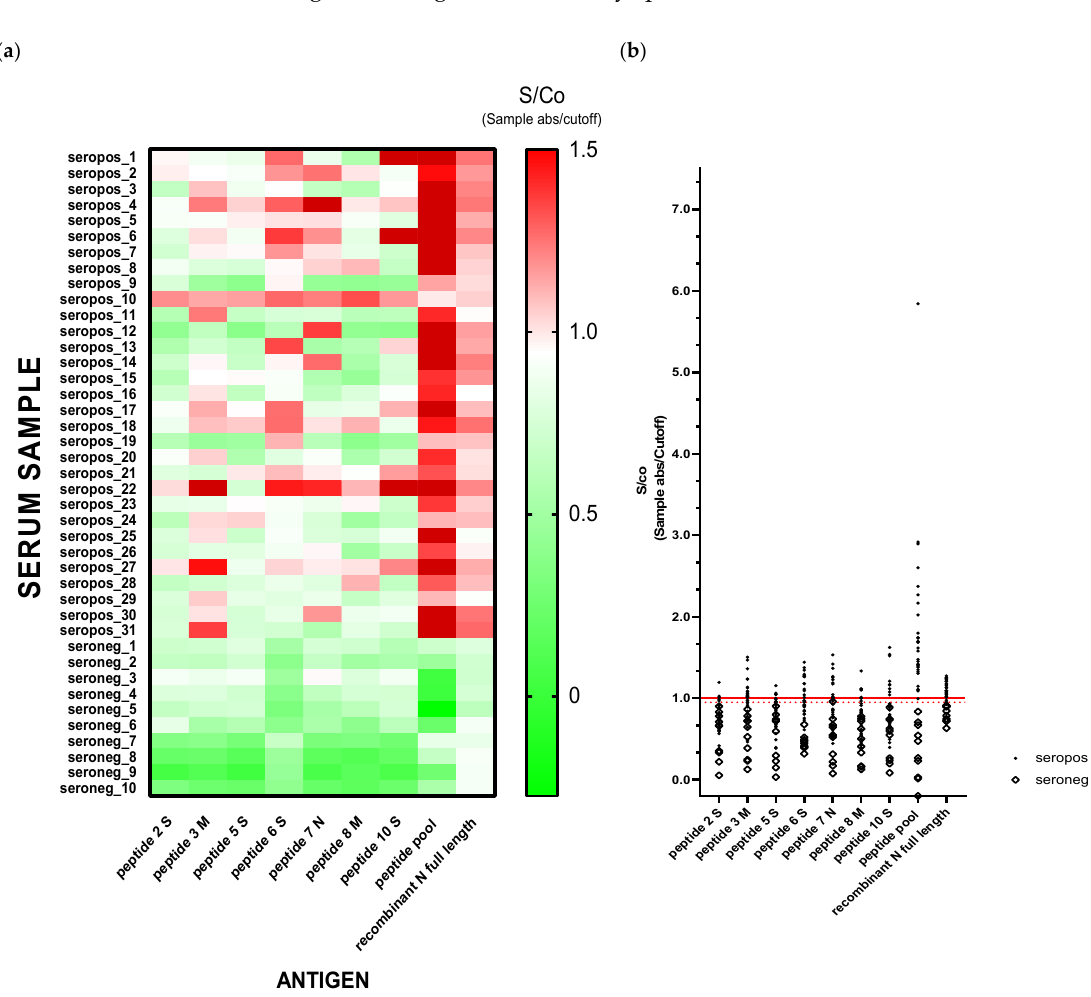
Figure 2. IgG immunoreactivity against 7 SARS-CoV-2 synthetic (singularly or pooled) peptides and against recombinant full length SARS-CoV-2 Nucleocapsid (N) of 41 sera collected during mass screening. Samples were considered IgG-positive to a specific antigen when S/Co ratio ( Sample absorbance/Cutoff , where Cutoff absorbance was determined from the mean of pre-COVID human negative sera absorbance at 450nm plus 2.5 standard deviations) scored ≥ 1 (red blocks) and negative if S/Co ratio scored <0.9 (green blocks), whereas in white are represented samples with intermediate S/Co ratio. Data in the heat map, ( a ) and in the scatter plot, ( b ) are representative of three independent experiments carried out in duplicate.